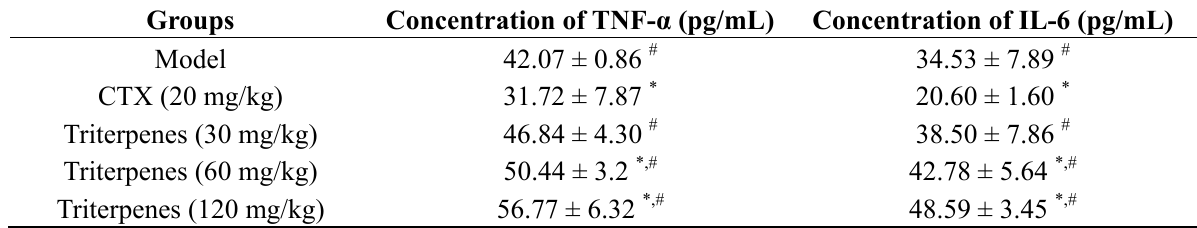
Table 1. Comparison of TNF- α and IL-6 of triterpenes in vivo